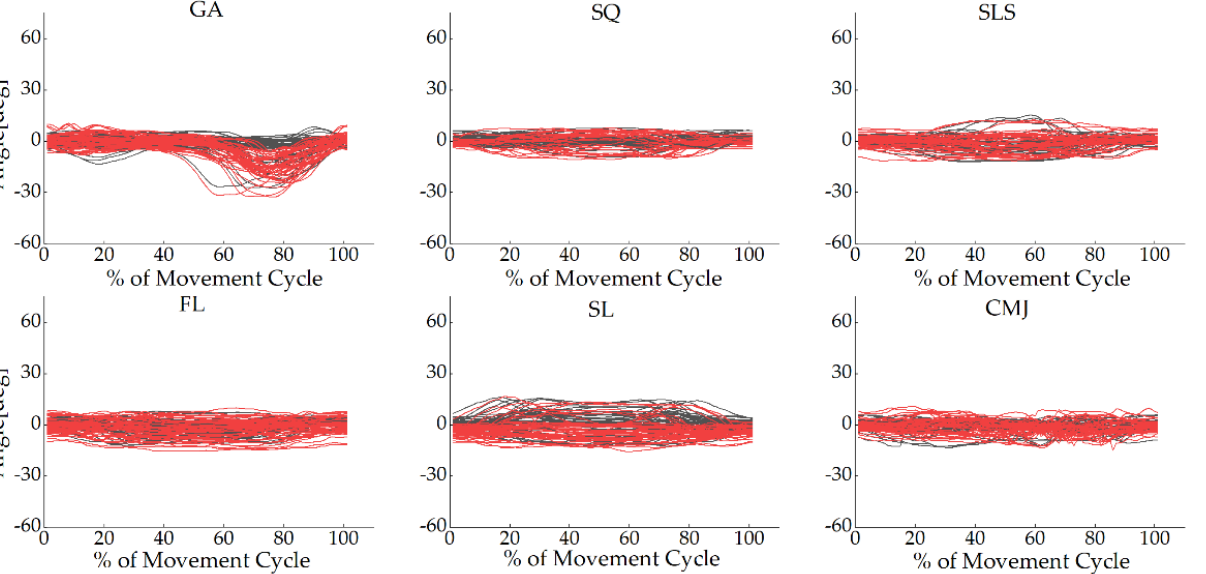
Figure A3. Knee joint angles in the frontal plane for each participant in all tasks during the movement cycle of the gait (GA), squat (SQ), single-leg squat (SLS), side lunge (SL), forward lunge (FL), and counter-movement jump (CMJ). The black lines represent the OptiTrack system, while the red lines represent the Perception Neuron ® system. The Y -axis depicts joint angles in degrees, while the X -axis depicts the movement cycle in %.